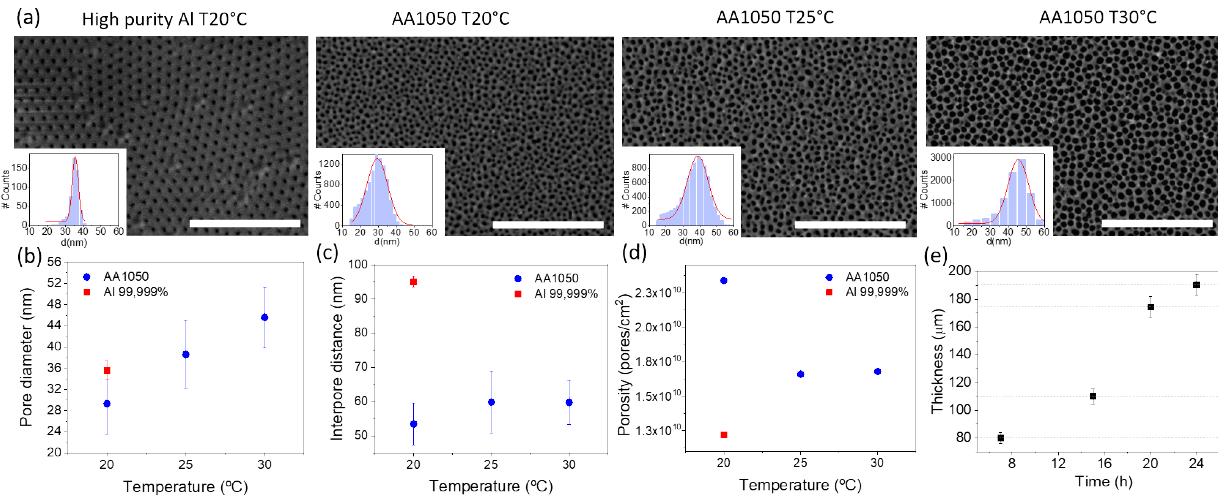
Figure 2. ( a ) Top-view images of AAO templates, anodized from different starting materials in 0.3 M oxalic acid, applying 40 V over 2 h at different temperatures. Histograms represent the pore size distribution and is calculated from different images, using ImageJ software. The scale bar is 1 µ m in all images. ( b ) Pore diameter ( c ) interpore distance and ( d ) pore density vs. anodization temperature for Al 99.999 % and AA1050, calculated from the images in ( a ). Error bars are calculated from the standard deviation of the Gaussian fits of the histograms. ( e ) Evolution of the thickness of alumina templates as a function of the anodization